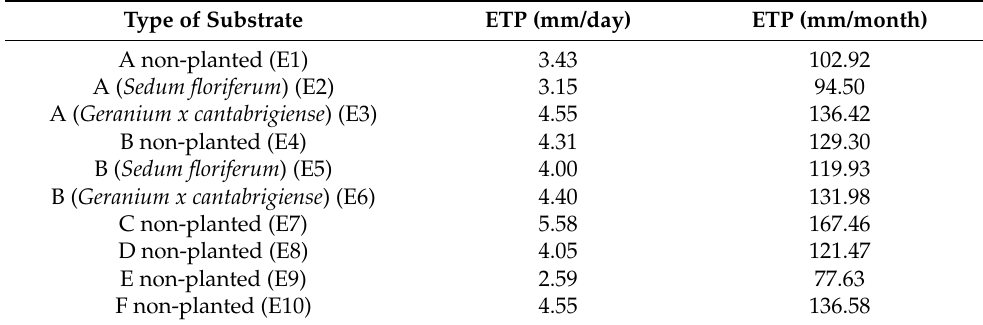
Table 5. Overview in evapotranspiration per m 2 of the used technical soils A–F (A and B non-planted, planted with Sedum floriferum and Geranium x cantabrigiense , and C–F non-planted), while using the newly developed equations